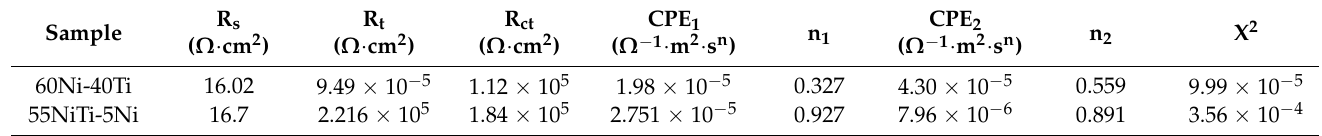
Figure 14. The equivalent electric circuit of coatings and a schematic representation of the passive film with the interpretation of the circuit. Table 6. Nyquist plots parameters of coatings.